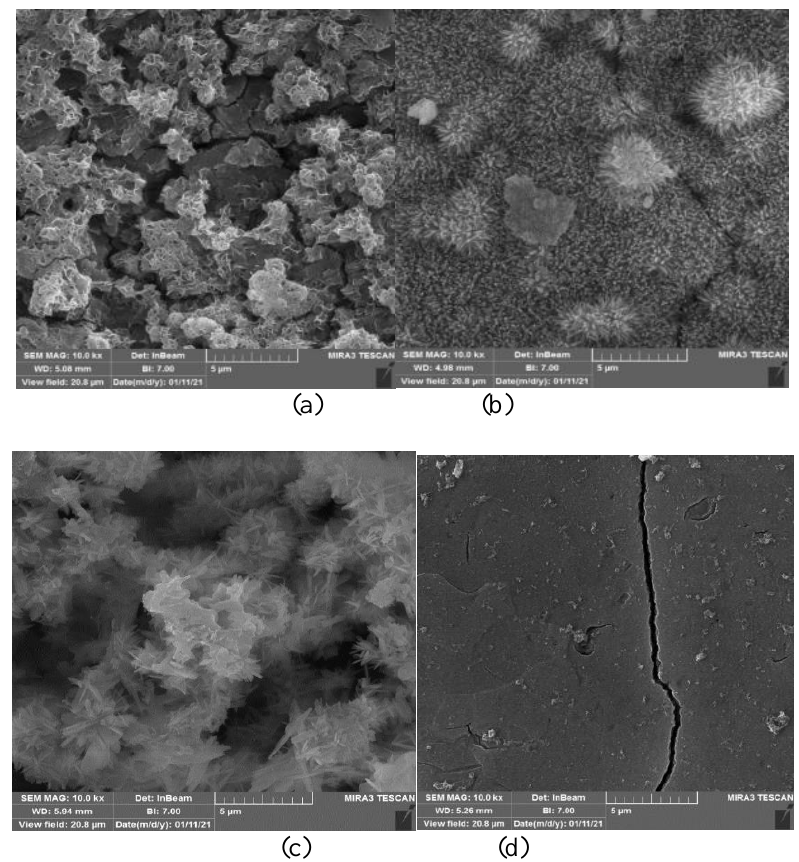
Fig. 15. SEM of (a) blank (b) 250 mg/L (c) 500 mg/L (d) 750 mg/L of